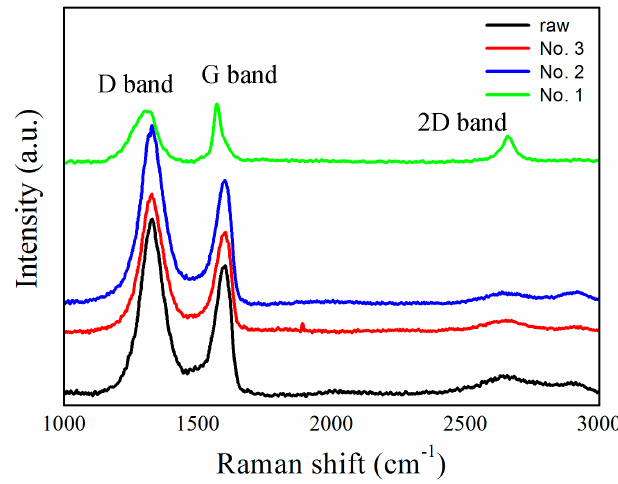
Figure 5. Raman spectra of recovered samples produced by pulsed iron wire discharge in GO suspension. The spectrum of the raw GO is given for comparison.